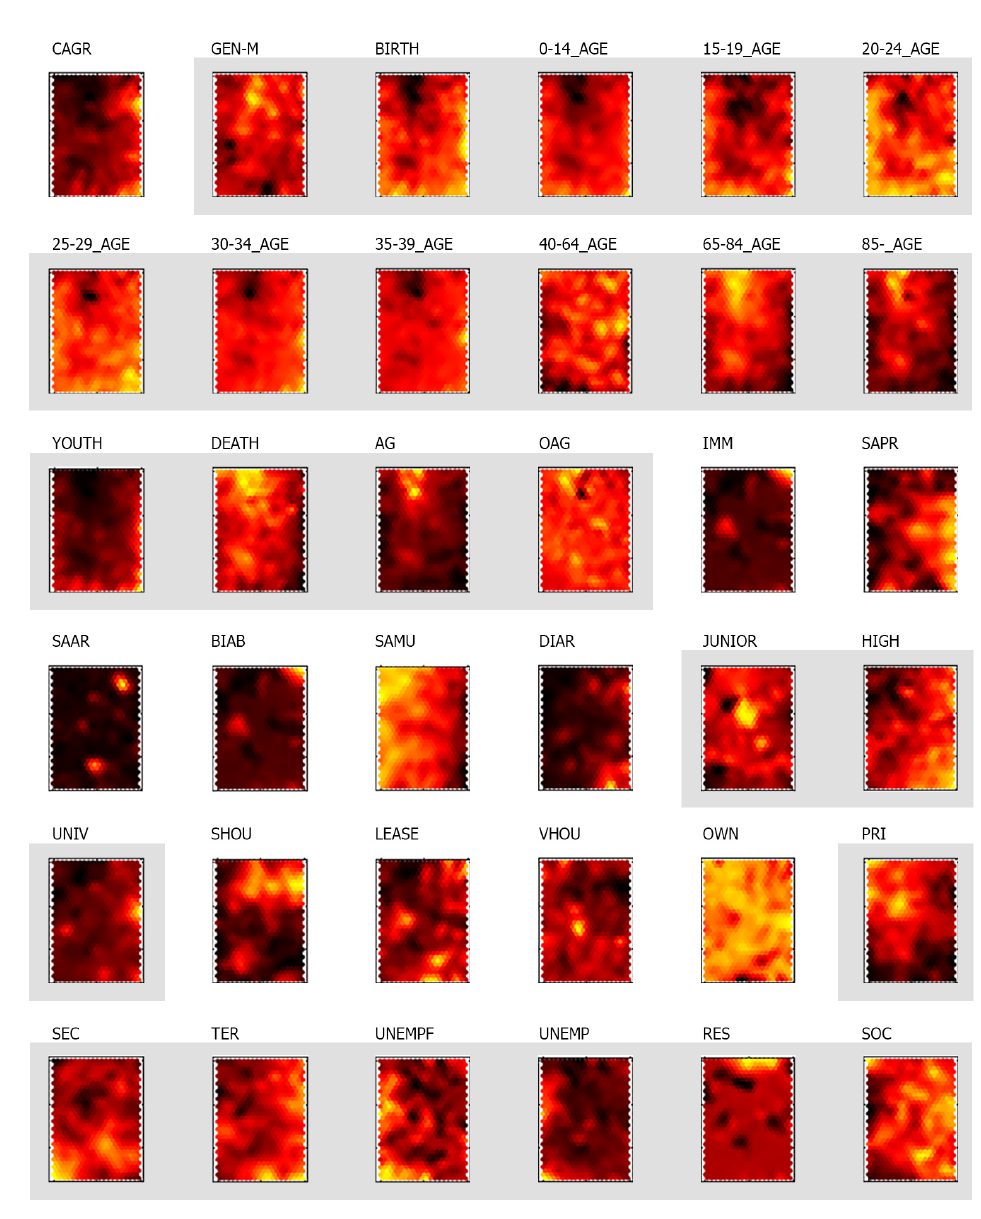
Figure 4. Component planes. High scores are depicted in yellow, and low ones are in